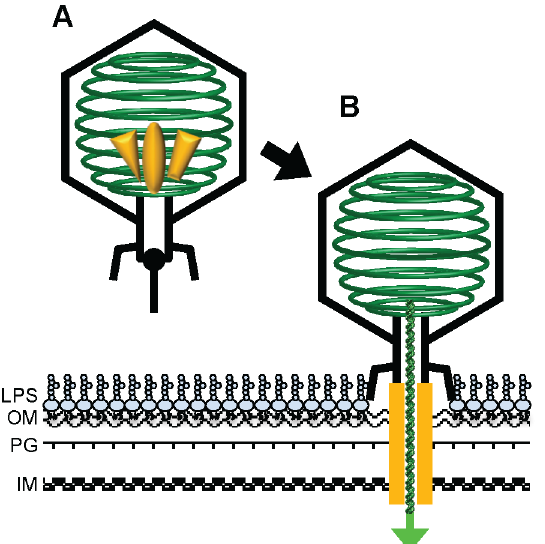
Fig 5. Schematic representation of translocation of the DNA-injection proteins and the assembly of the DNA-injection device in the host envelope. (A) The three DNA-injection proteins, gp12, gp11 and gp13, represented with an oval, triangle and trapezoid in blue, are packed in the phage particle. Note that the copy numbers of those proteins in the capsid and how they are arranged are not known. (B) upon attachment to the host cell, the DNA-injection proteins are translocated through the tail channel to the host cell envelope, where they assemble into an extended tube-like structure to allow delivery of phage DNA into the host cytoplasm. The arrangement of those proteins is not known and is drawn schematically. LPS, lipopolysaccharide; OM, outer membrane; PG, peptidoglycan; IM, inner membrane. The phage dsDNA is in